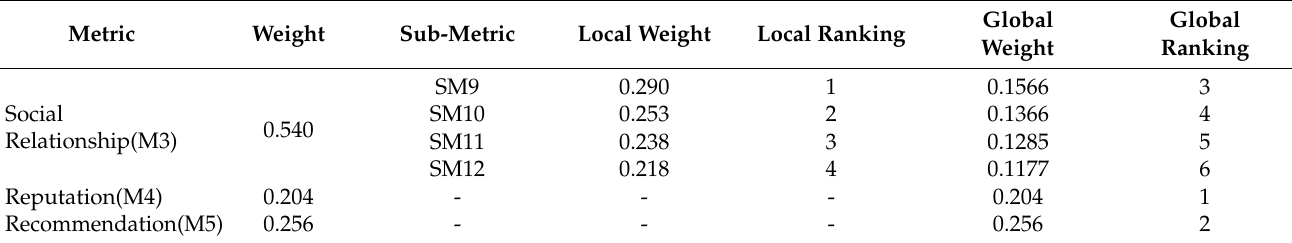
Table 20. Summarization for the evaluation of trust metric for